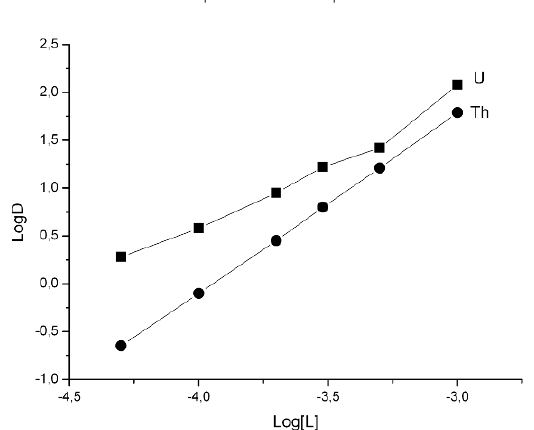
Figure 3. Influence of the concentration of compound 8 in dichloroethane on the extraction of Th(IV) and U(VI) from 4 M NH NO 4 3